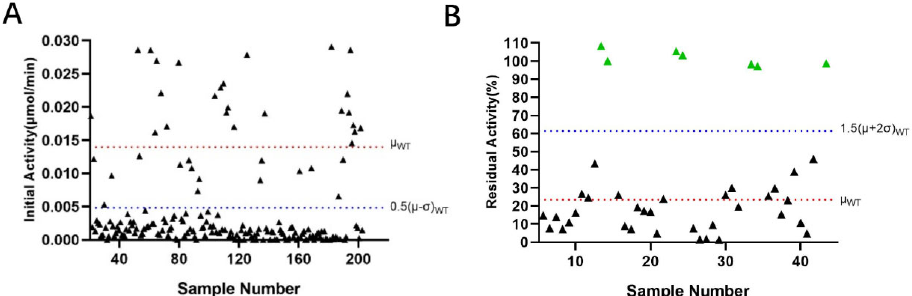
Figure 5. Screening results of the site-saturation mutagenesis library. ( A ) The initial activity of all clones in the 292 site-saturation mutagenesis library. The red dashed line indicates µ WT , and the blue dashed line indicates 0.5( µ WT − σ WT ). µ WT and σ WT are the average and standard error of the WT’s initial activity, respectively, which were calculated from a panel of 288 clones. In the first screening step, mutants with an initial enzyme activity higher than 0.5( µ WT − σ WT ) entered the second screening step. ( B ) In the second step, mutants with a residual activity above 1.5( µ WT + 2 σ WT ) were sequenced (labeled in